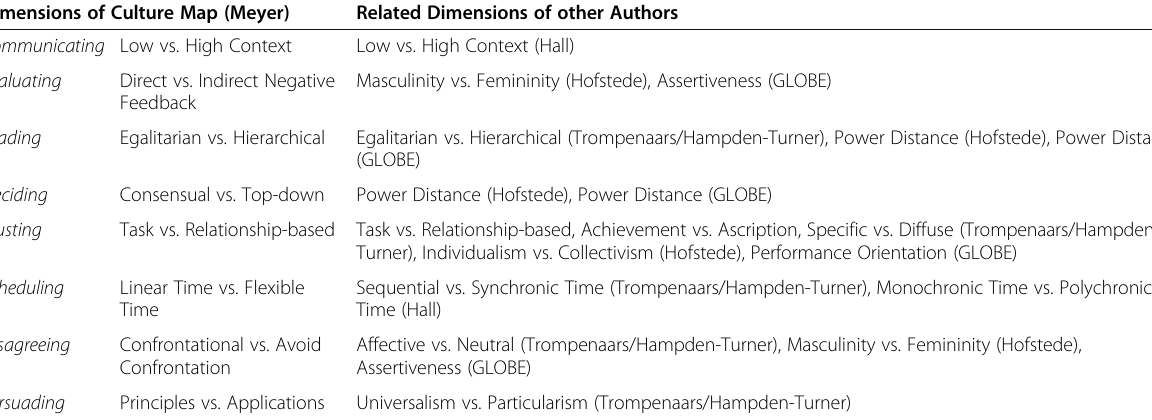
Table 1 Cultural dimensions of the Culture Map Dimensions of Culture Map (Meyer) Related Dimensions of other Authors Communicating Low vs. High Context Low vs. High Context (Hall)